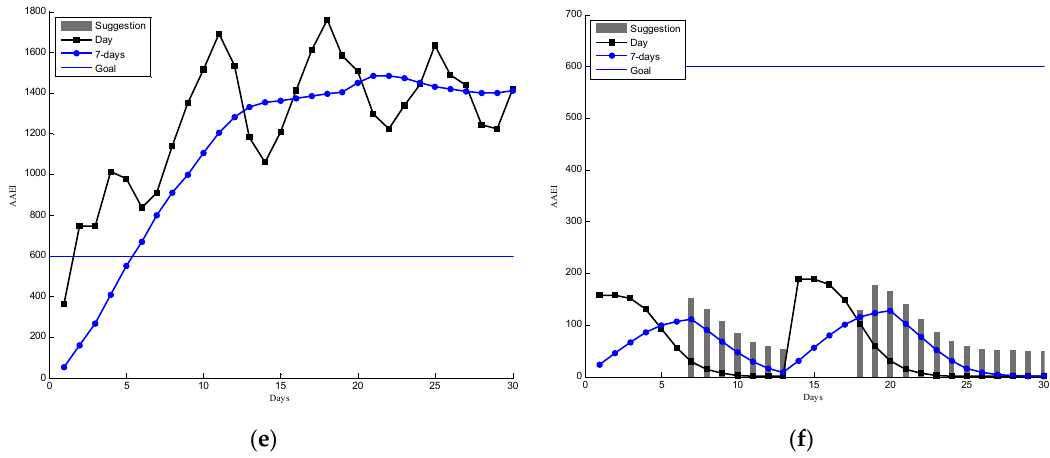
Figure 12. Different cases of recorded AAEI and prompting values in the real-world trail. ( a ) A case increase physical activity to achieve the goal; ( b ) a case increase physical activity near the goal; ( c ) and ( d ) two different cases that exercises sometimes; ( e ) a case achieve the goal without any prompts;